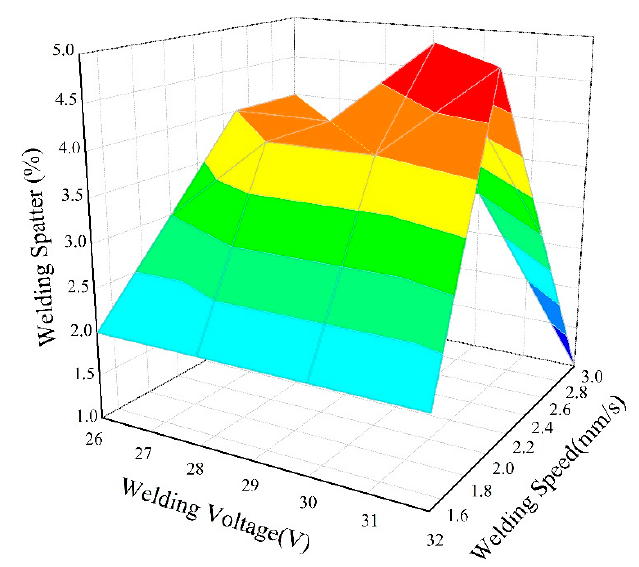
Figure 6. Interaction of welding speed and arc current on welding spatter.